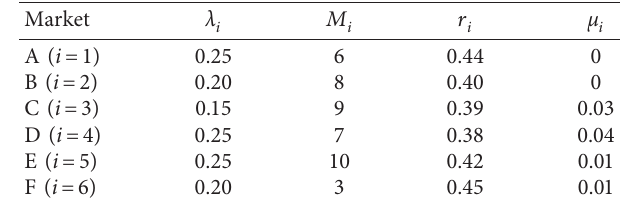
Table 2: Parameters of each